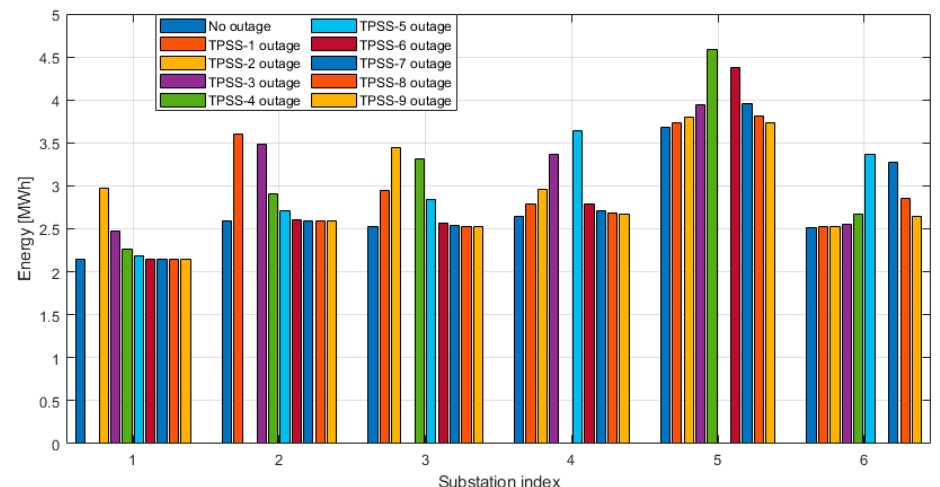
Figure 17. Energy consumption of substations with various outage modes.